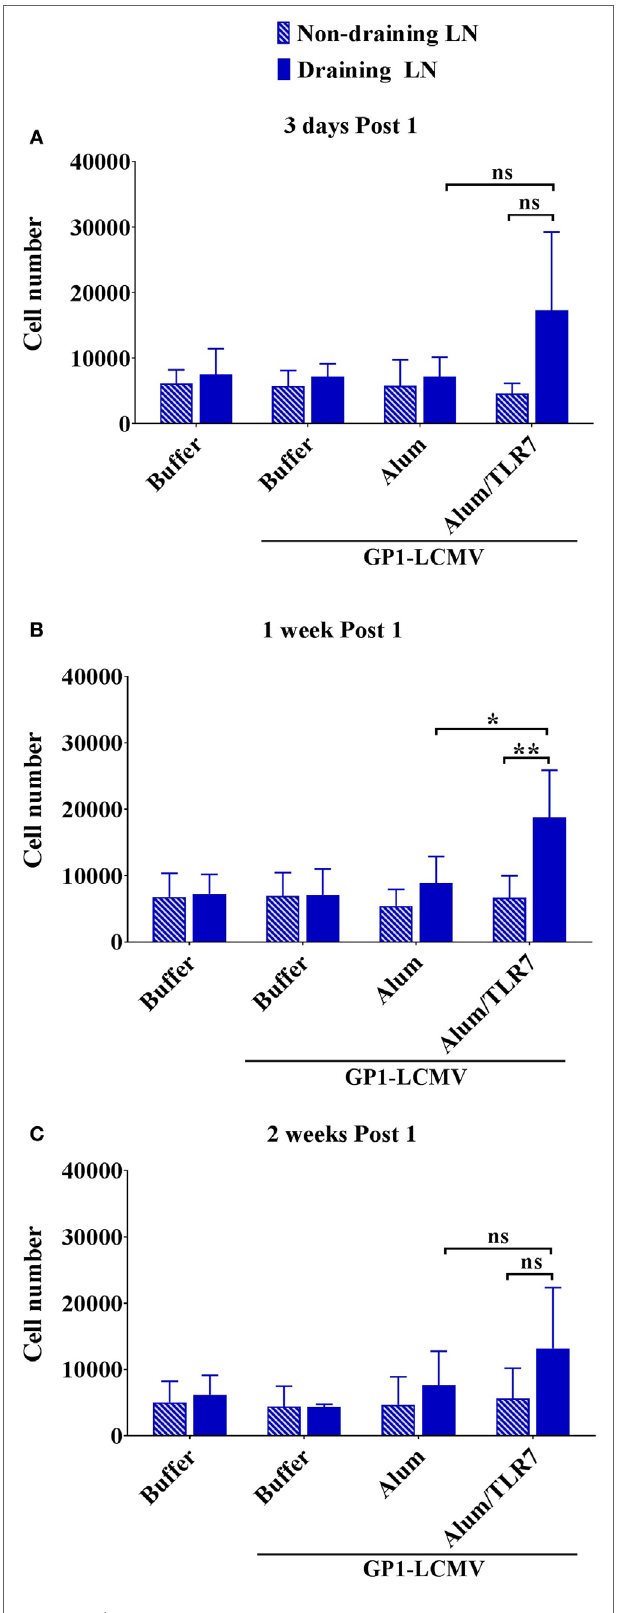
FigUre 4 | Alum/toll-like receptor (TLR)7 promotes recruitment of non-proliferated naïve antigen-specific B cells within draining lymph nodes (LNs). Bar graphs reporting the number of naïve non-proliferated antigen- specific B cells within draining LNs (filled blue bars) and contralateral non-draining LNs (striped blue bars) from mice treated as indicated and collected 3 days (a) , 1 week (B) , and 2 weeks (c) after the immunization. Bar graphs plot the average results, with SD, of five independent experiments. Statistics: Mann–Whitney two-tailed test: ** P < 0.01, * P <